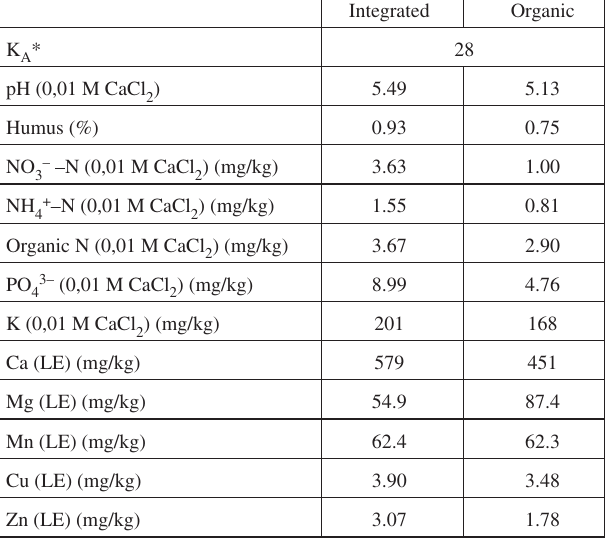
Table 1. Soil analytical results of examined orchard parts (2002–2004, average) Integrated